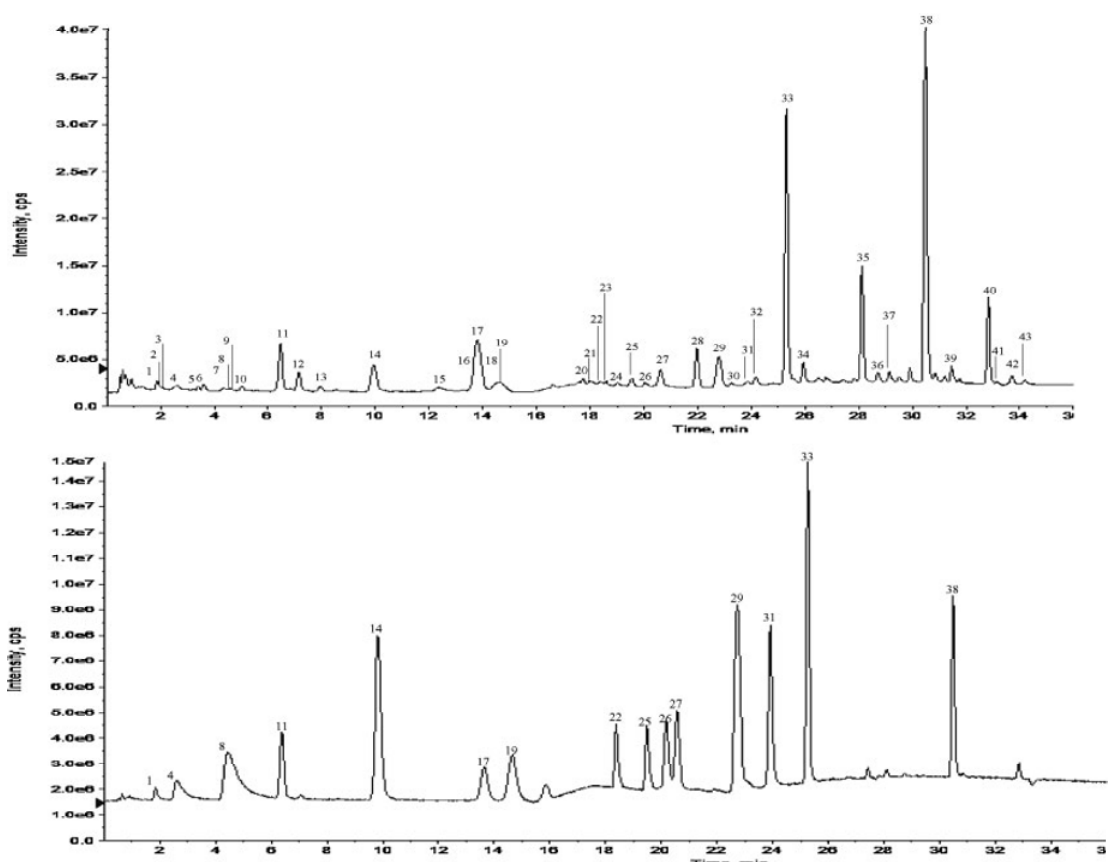
Figure 8. Total ion chromatograms of methanolic extract of Aconitum carmichaeli (a) and 15 authentic standards (b) by RRLC/TOFMS with a fragmentor voltage of 120V in positive ion mode. Chromatographic separation was carried out on an Agilent Zorbax Extend C18 column. The mobile phase consisted of 10mM ammonium acetate buffer solution adjusted to pH at 9.6±0.2 with 28% ammonia solution and ACN